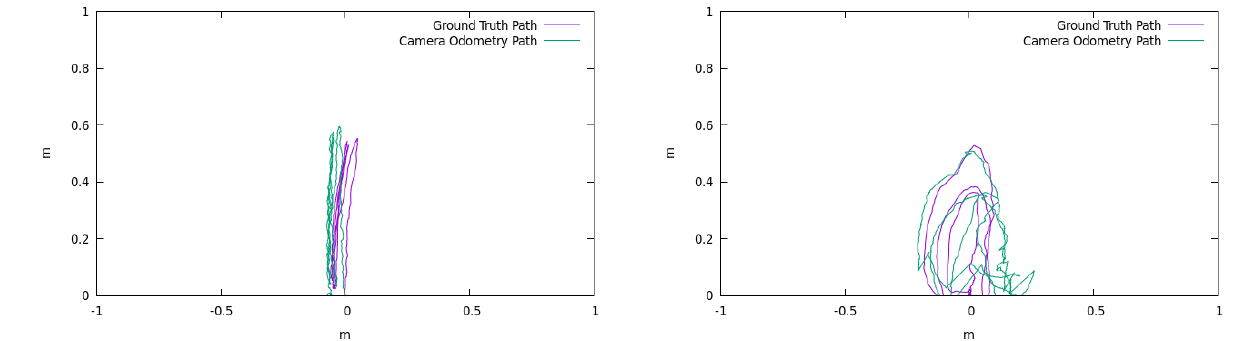
Figure 5. Tracking path for linear movement with calibrated camera.